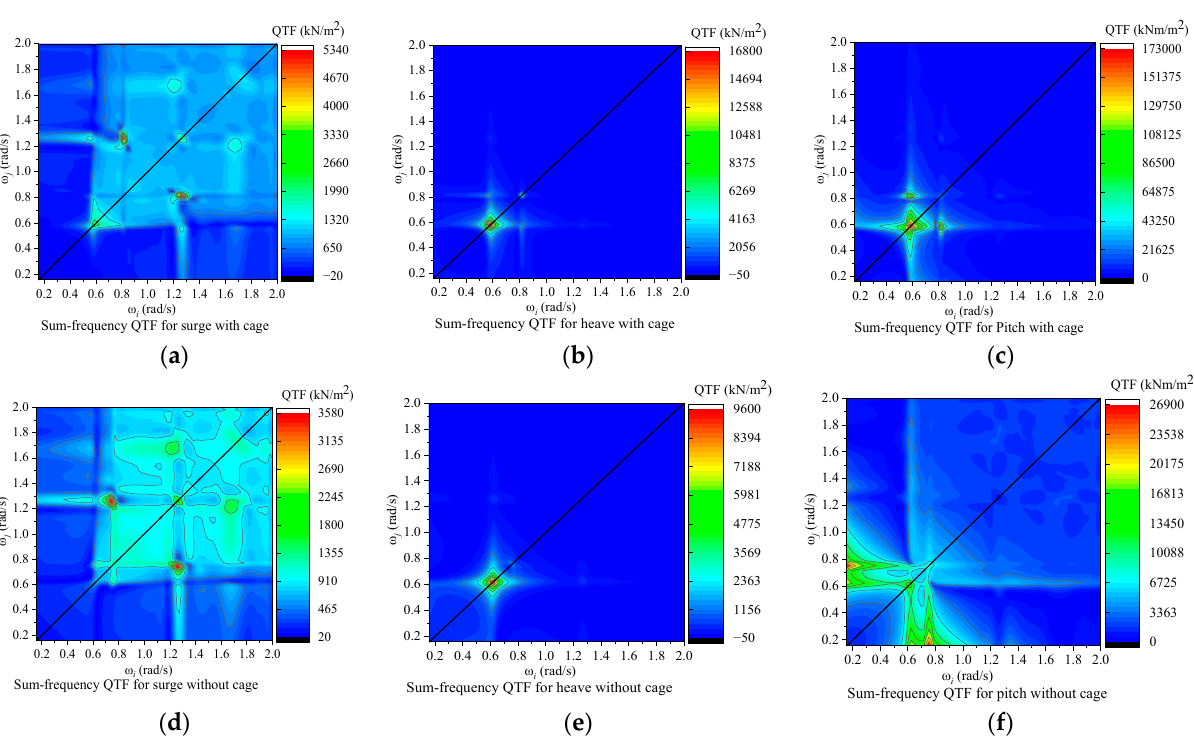
Figure 12. Second-order sum-frequency QTFs of the barge-type FOWT-AC and barge-type FOWT for a zero-degree wave heading: ( a ) Surge of FOWT-AC; ( b ) Heave of FOWT-AC; ( c ) Pitch of FOWT-AC; ( d ) Surge of FOWT; ( e ) Heave of FOWT; ( f ) Pitch of